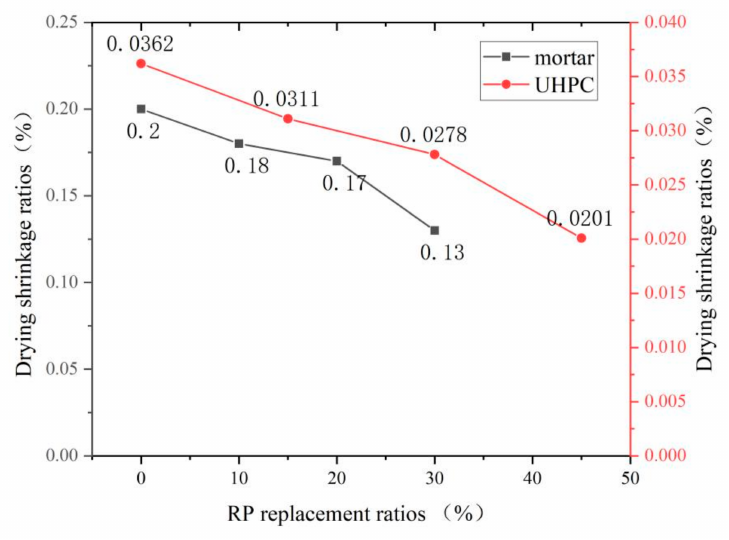
Figure 9. Drying shrinkage of mortar and ultra-high-performance concrete with different replacement rates of RP.